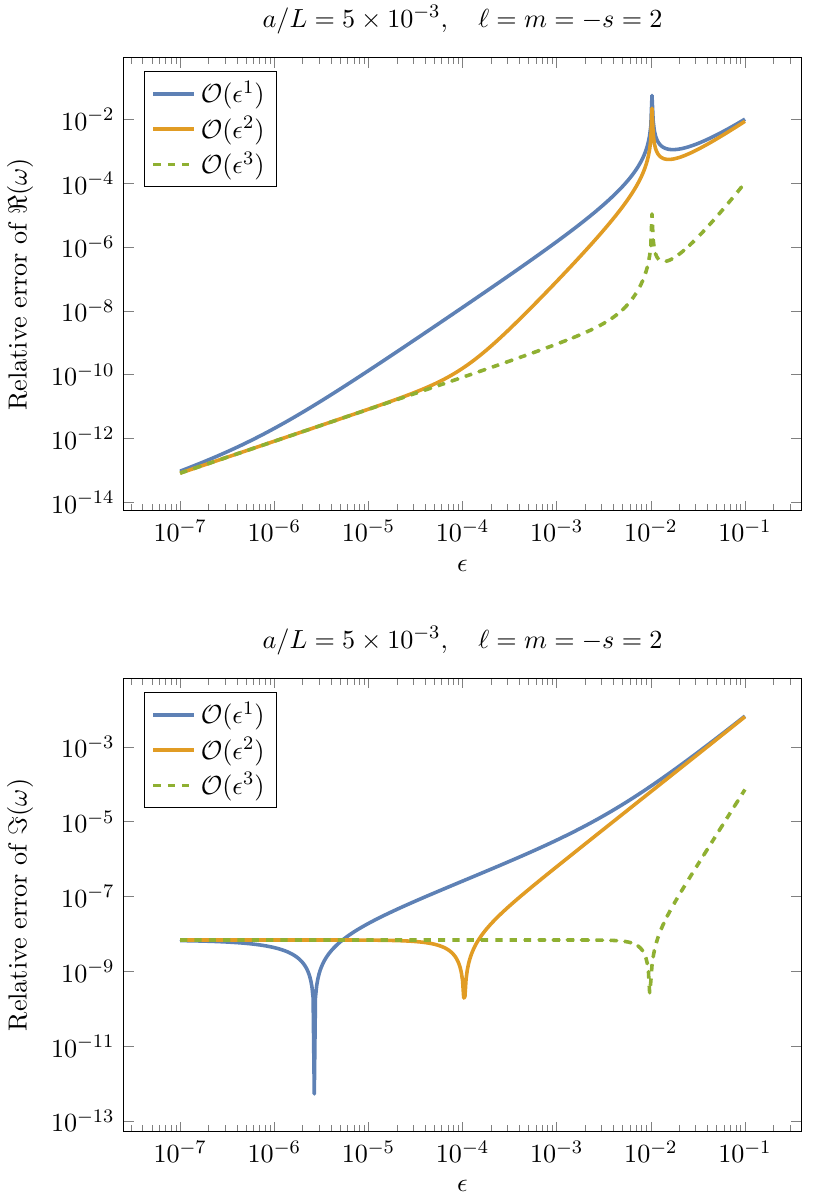
Figure 6 . Similar to (cid:12)gure 5 but here it refers to the QNM frequency expansion about m (cid:10) C instead of m (cid:10) + (i.e., the right hand side of eq. (1.1) after taking (cid:10) +